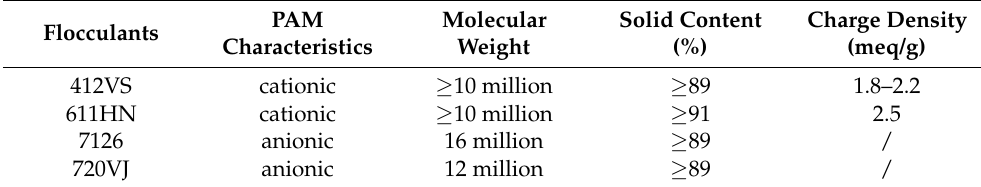
Table 2. Chemical properties of PAM used in this study.